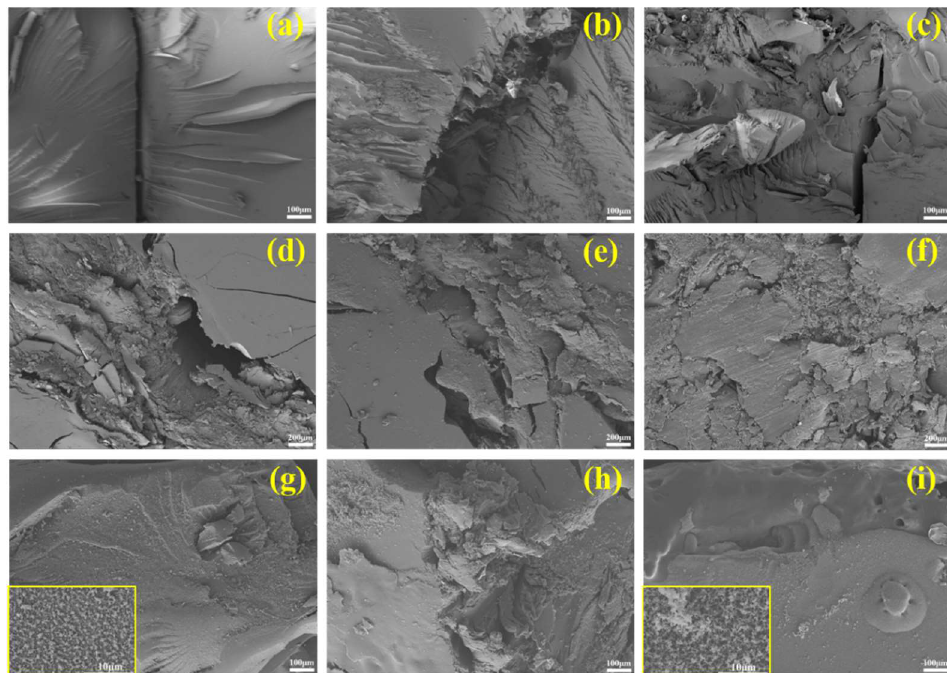
Figure 7. SEM images of section morphology of ( a ) pure EP, ( b ) EP/BCI/BSEA-2 and ( c ) EP/BCI/BSEA-5; surface morphology of ( d ) pure EP, ( e ) EP/BCI/BSEA-2 and ( f ) EP/BCI/BSEA-5 with no reaction; morphology of ( g ) explosion samples, ( h ) flash sample of pure EP and ( i ) burning sample of EP/BCI/BSEA-2 after liquid oxygen compatibility impact test.